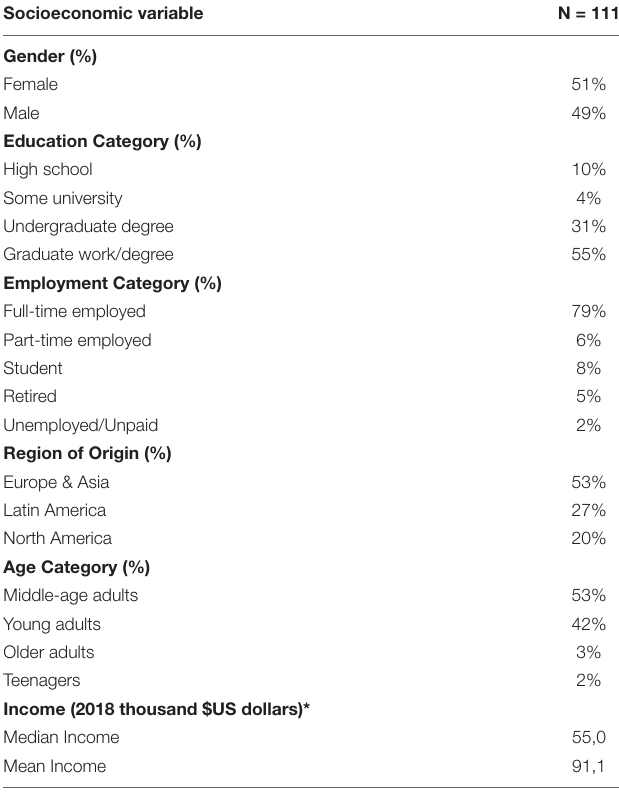
TABLE 1 | Socio - demographic variables.